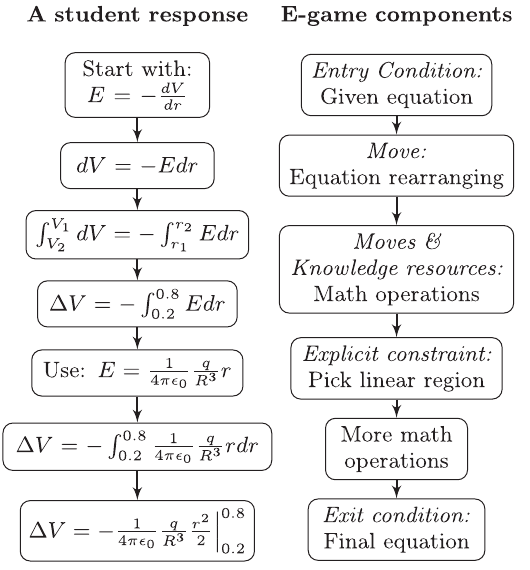
FIG. 7. Example of the analytical derivation epistemic game for solving the electrostatics problem.